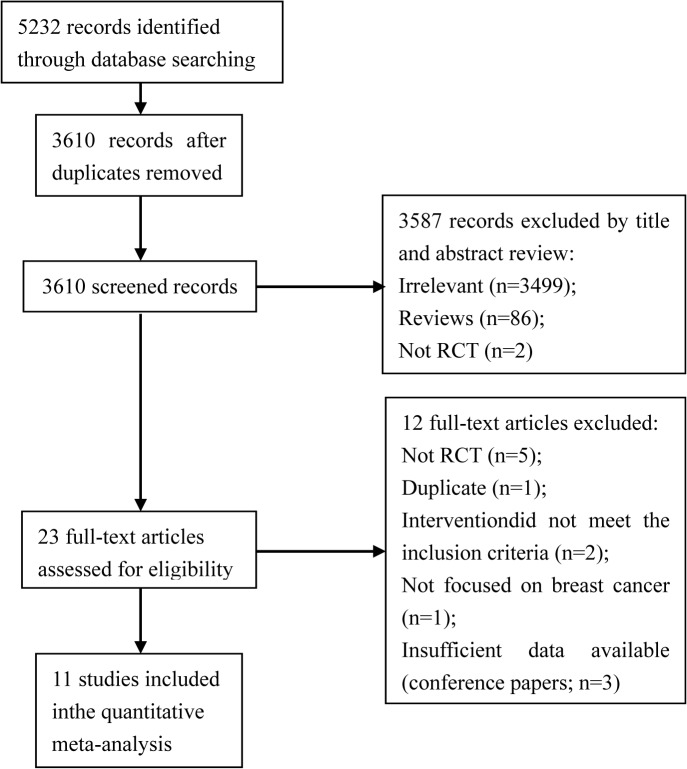
Study flow diagram.